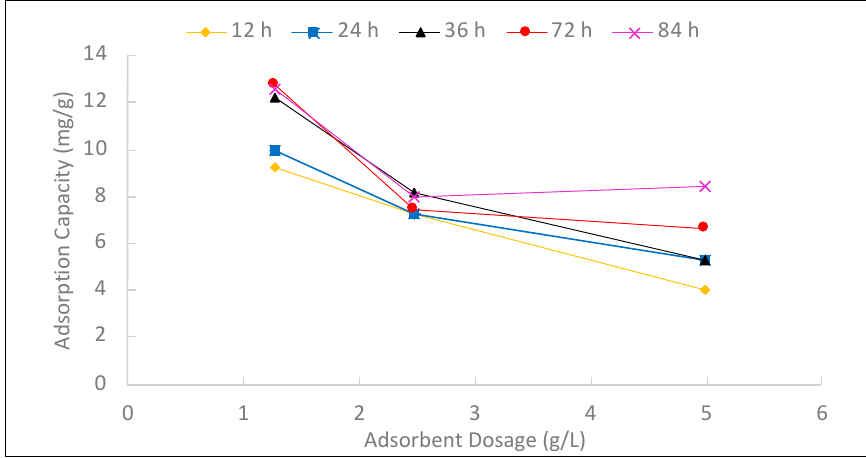
Figure 8. Screening of the adsorption capacity of CS-MB with Cu 2+ as a function of adsorbent dosage at different time intervals. Table 3. Adsorption performance of modified CS hydrogel system.